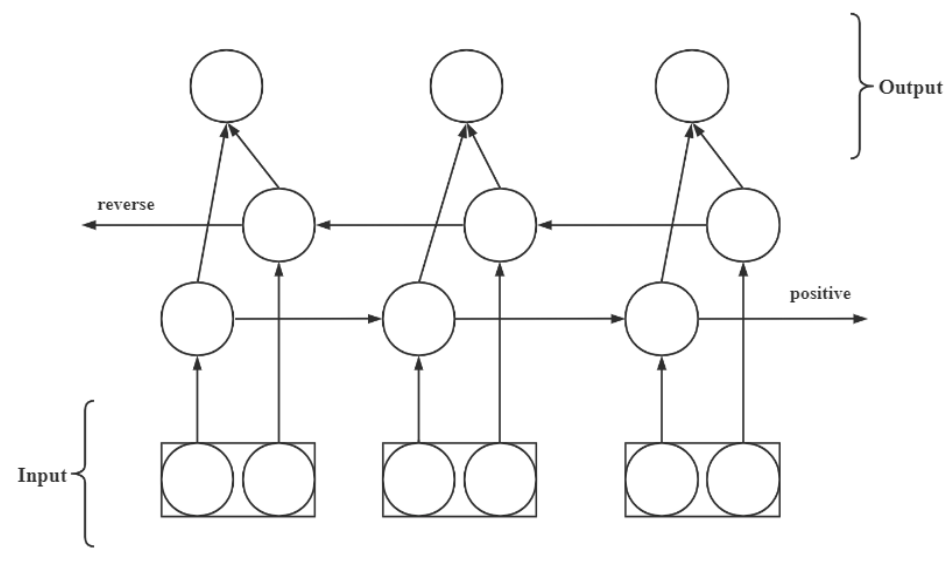
Figure 5. The architecture diagram of Bi-Directional Long Short-Term Memory network model.